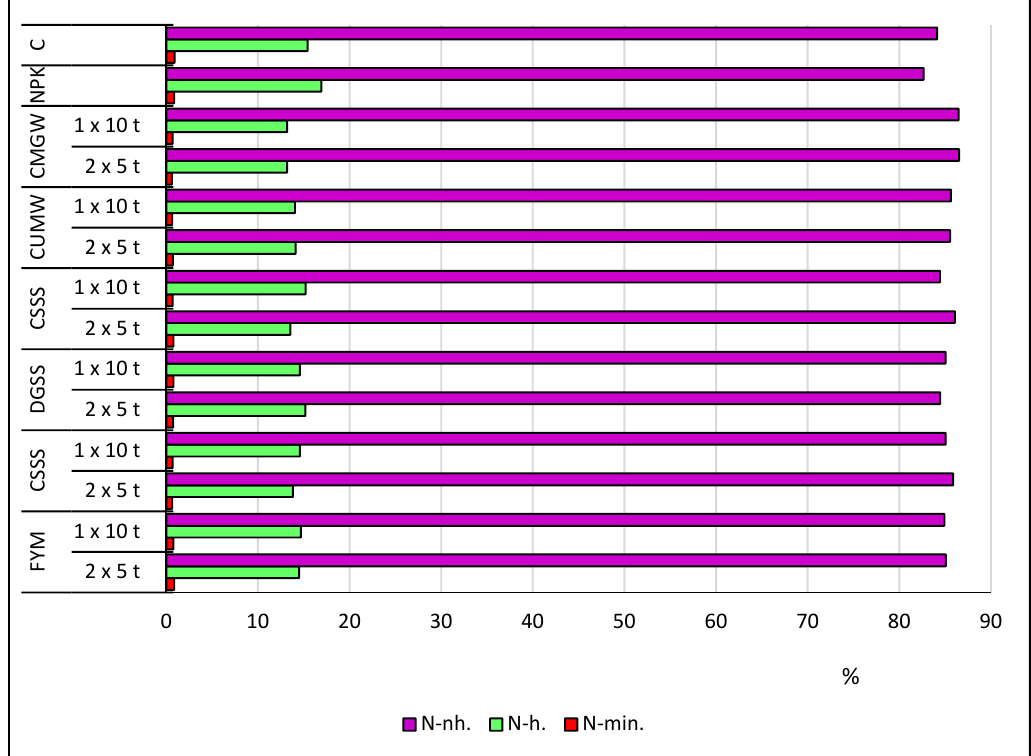
Figure 3. Structure of nitrogen compounds in soil (N-nh.—non-hydrolysable; N-h.—hydrolysable (easily + hardly); N- min.—N-mineral).